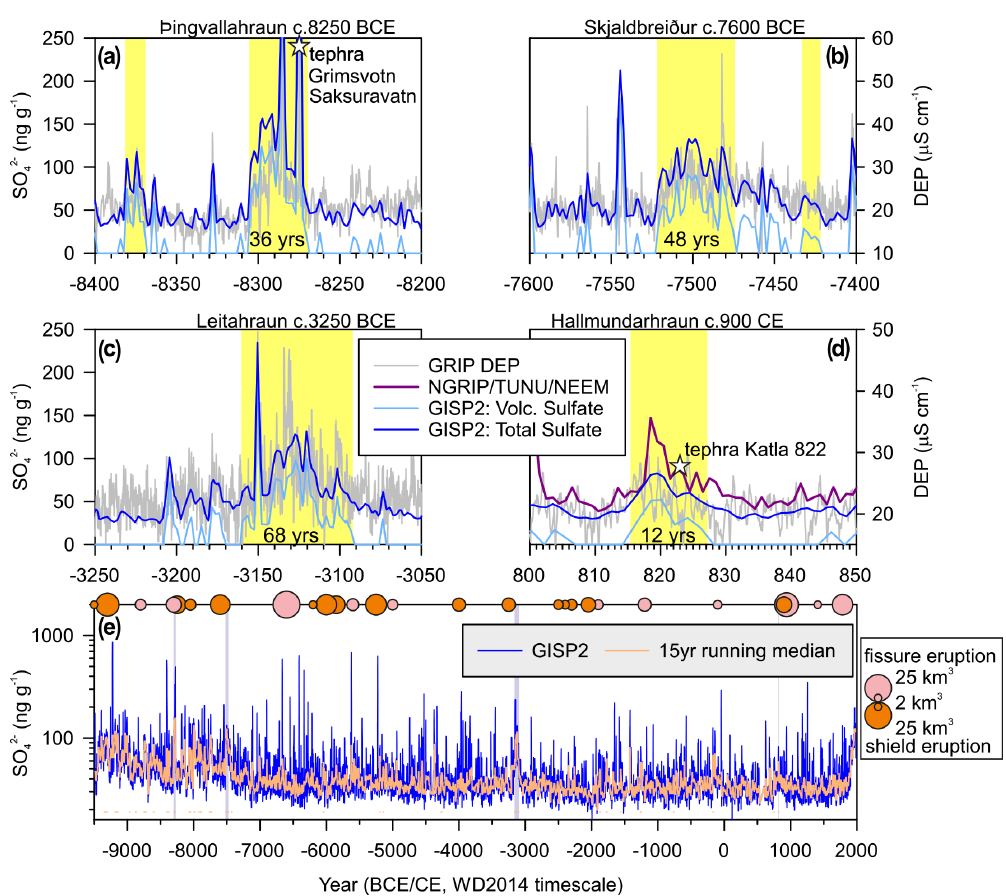
Figure 5. Prolonged eruptive episodes in Greenland ice cores. Panel (a) shows the GISP2 total sulfate and volcanic sulfate records and the GRIP DEP record between 8400 and 8200BCE; panel (b) shows the same records between 7600 and 7400BCE; panel (c) shows the same records between 3250 and 3050BCE; panel (d) shows the same records between 800 and 850CE as well as mean sulfate concentrations from a stack of three synchronized ice cores from Greenland (NGRIP, NEEM-2011-S1 and TUNU2013) on the NS1-2011 chronology (Sigl et al., 2015). Shading indicates the time periods and duration of prolonged volcanic activity (Hjartarson, 2003; Sinton et al., 2005); stars mark tephra from Icelandic sources identified in ice cores from NGRIP, GRIP, NEEM, GISP2 and TUNU2013. Panel (e) shows the GISP2 sulfate record for the Holocene with a 15-year running